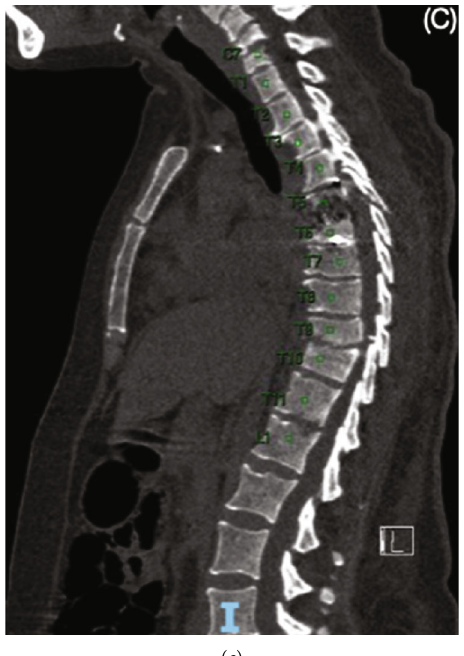
Figure 2: Postoperative x-ray of the thoracic spine: (a, b) postoperative changes are visualized at the level of the bony structures by left lateral instrumentation, with an intersomatic cage prosthesis at the level of T6-T7; (c) bone structures with postsurgical changes due to instrumentation in the thoracic spine, observing fi xation screws and bar from the body of T4 to the body of T7.